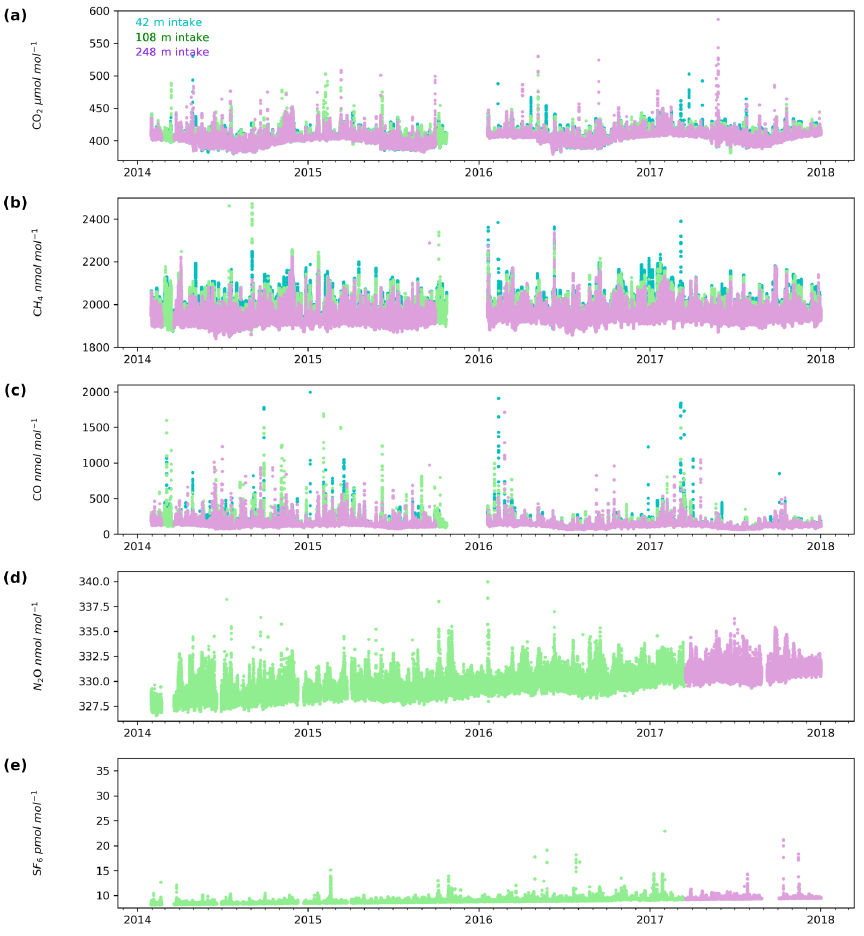
Figure 4. Minute-mean (a) CO 2 , (b) CH 4 and (c) CO and 10min discrete (d) N 2 O and (e) SF 6 observations at the Bilsdale site for the 42m (blue), 108m (green) and 248m (purple) intake